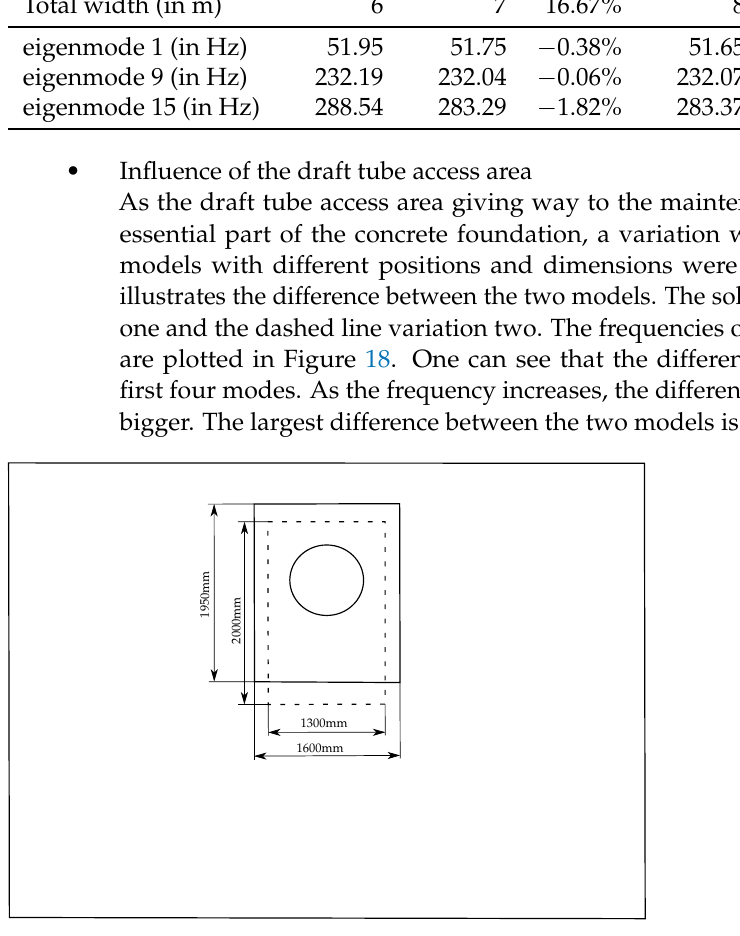
Figure 17. Influence of draft